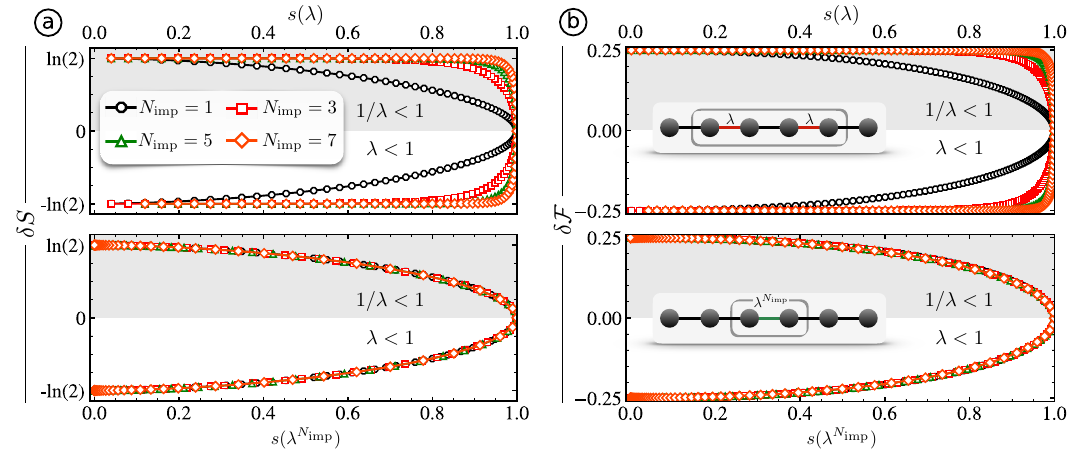
Figure 5: Parity effects of a (cid:13) the entanglement entropy and b (cid:13) the fluctuations when transitioning from the single impurity link to an “SSH-like” impurity with a collection of alternating bonds J , λ J . Upon increasing the number of impurities N with all λ 〈 2 n ,2 n + 1 〉 = λ , the differences quickly saturate to ± ln2 (upper panel a (cid:13) ) and ± 1 / 4 (upper panel b (cid:13) ). This can be understood in terms of an effective, stronger single impurity with strength λ N imp . When rescaling δ S and δ curves become equivalent (lower